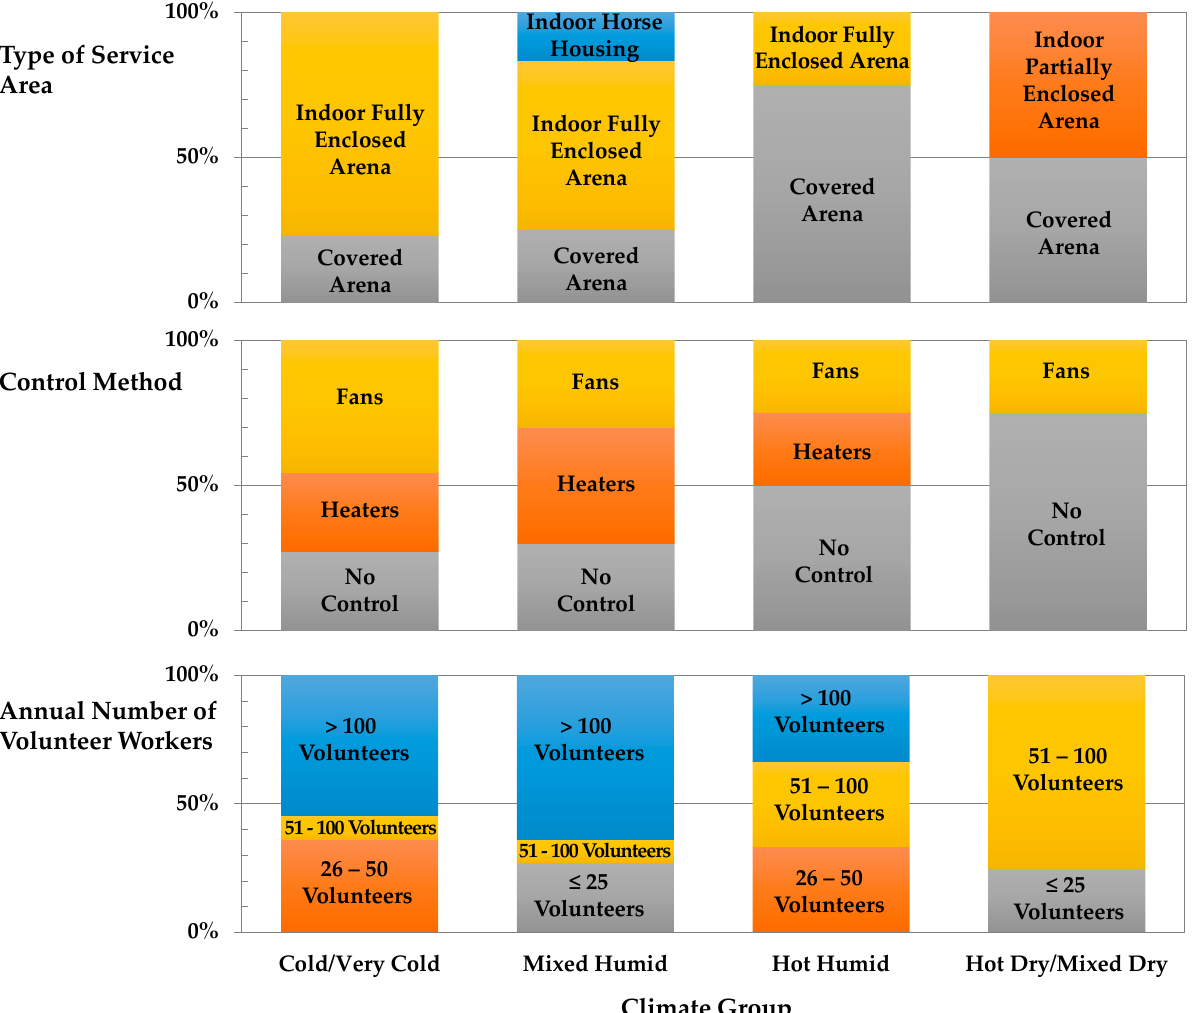
Figure 3. Major findings relevant to goals of the Future of Work Initiative.